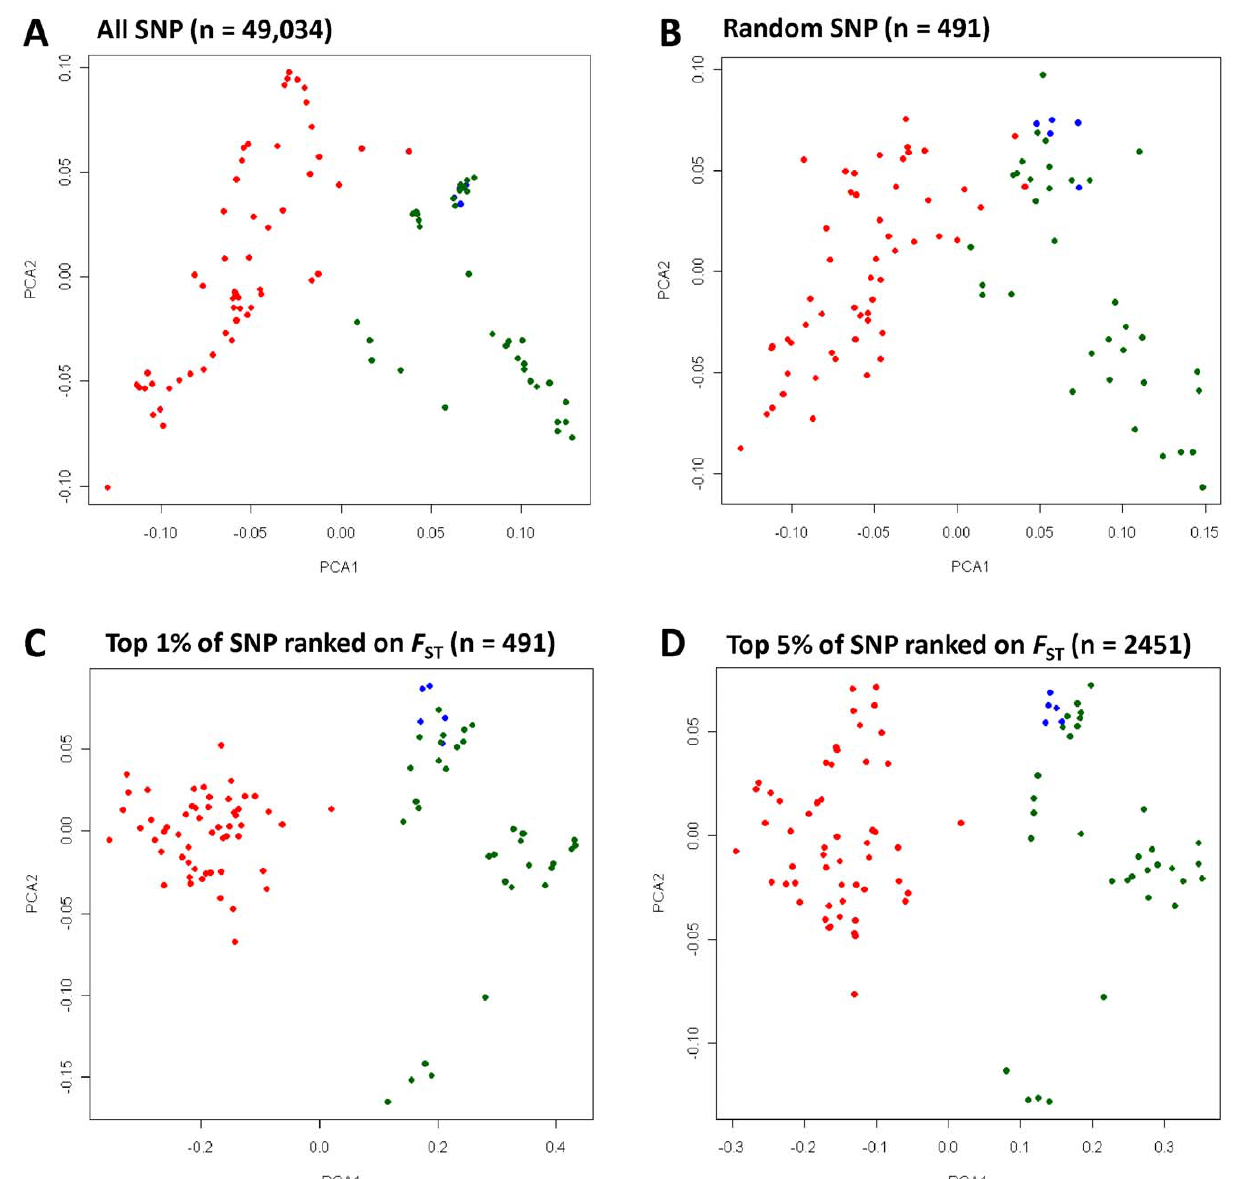
Figure 2. Clustering of animals based on principal component analysis of allele sharing. Individual animals were plotted for the first (PCA1) and second (PCA2) principal components using colours to distinguish the Louisiana Natives (red), Florida Natives (green) and Cracker (blue) lines. Four SNP sets were used to explore the effect of marker number and divergence on clustering: ( A ) all 49,034 SNP; ( B ) a random sample of 491 (1%) of SNP; ( C ) the top 1% of SNP ranked using F ST ; ( D ) the top 5% of SNP ranked using F ST . Note that the scale for PCA1 differs between panels and that a larger proportion of the variation is captured by PCA1 using F ST ranked SNP (C) compared with a random selection of markers (B).